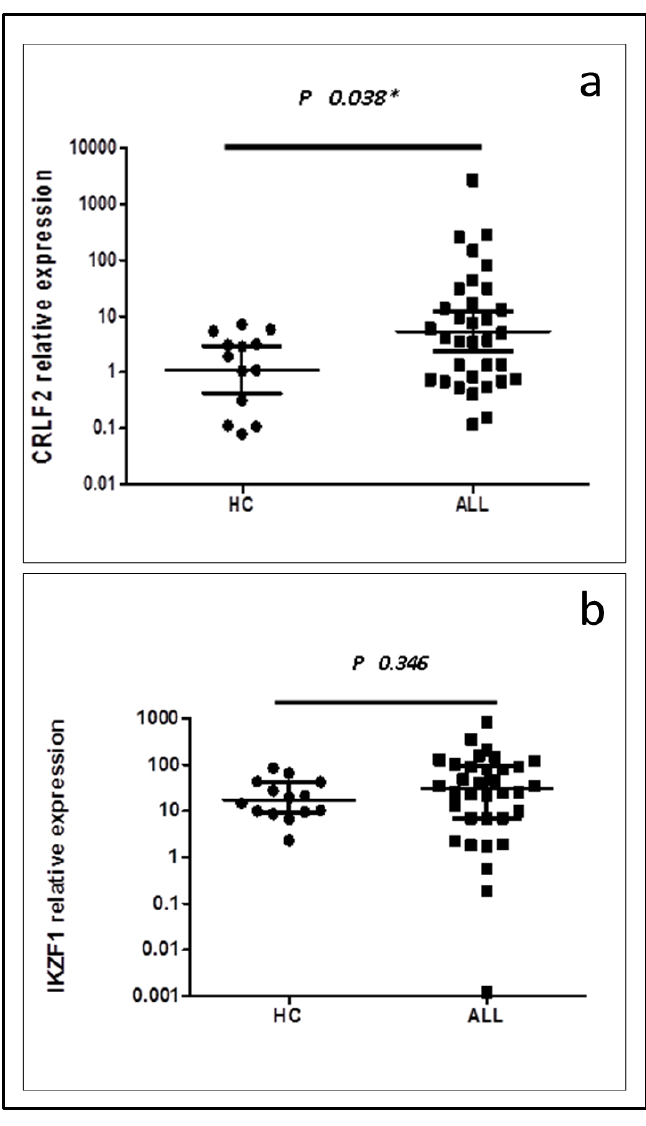
Figure 1: Comparing CRLF2 mRNA (a) and IKZF1 mRNA (b) expression in acute lymphoblastic leukemia (ALL) patients to that in healthy controls (HC) by qRT-PCR